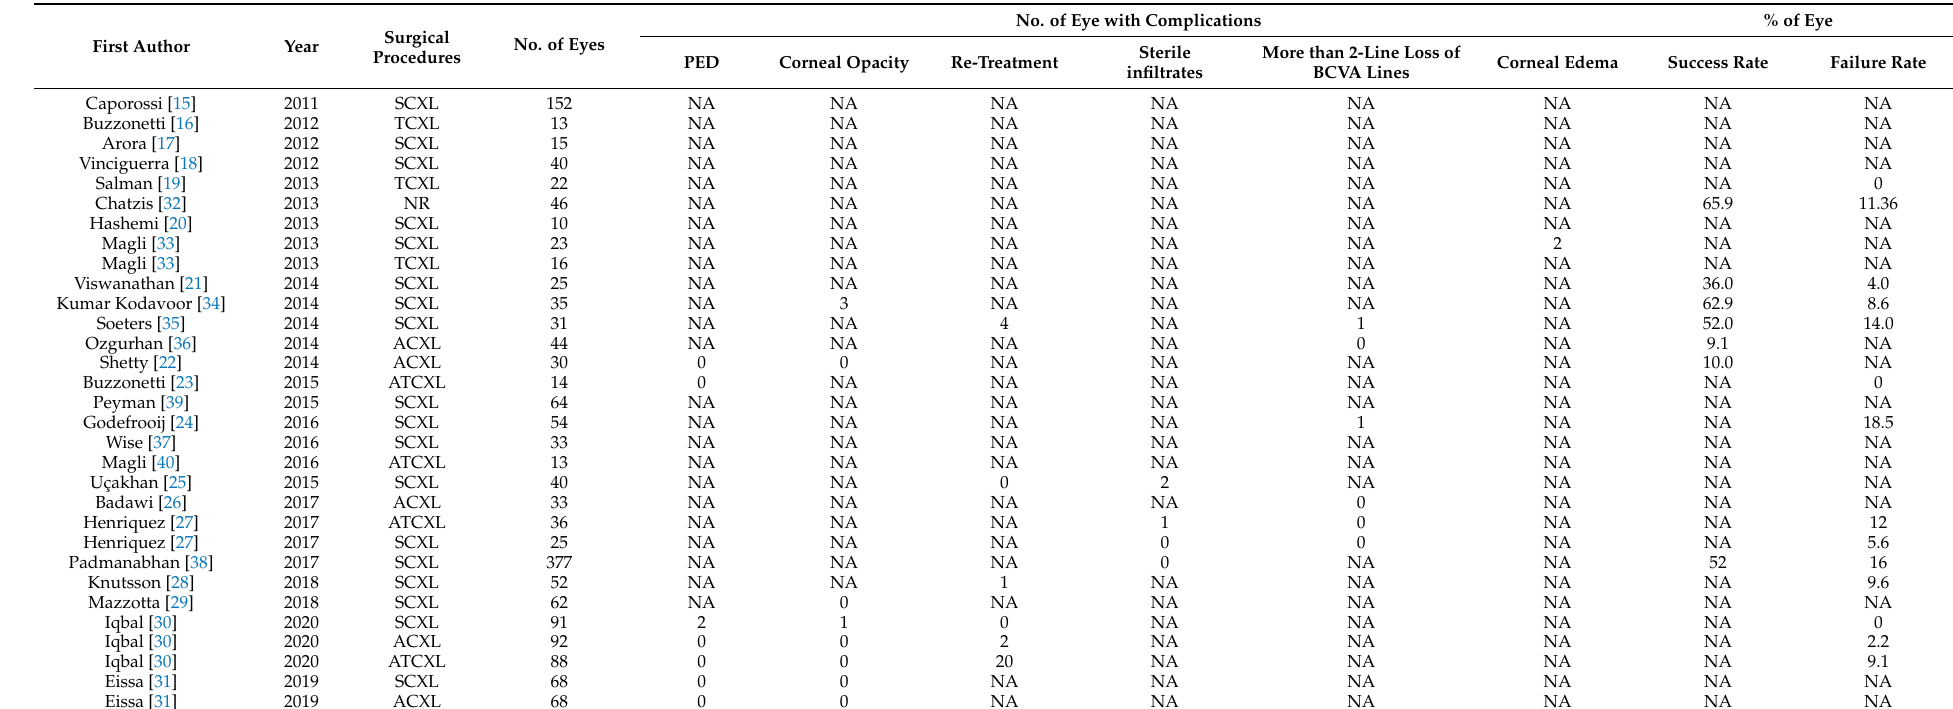
Table 2. Summary of complications of CXL after a 1-year